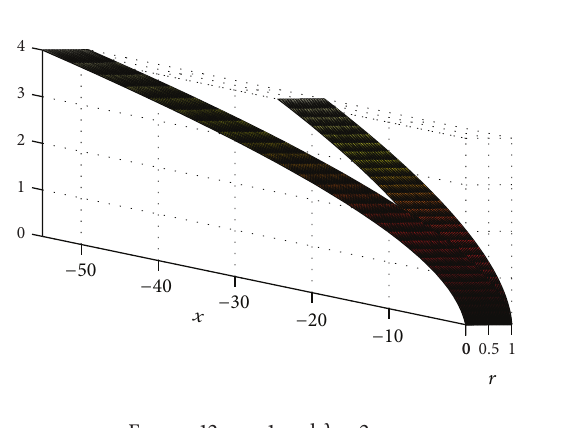
Figure 11: 𝛼 = 0.3 and 𝜆 = 2 .